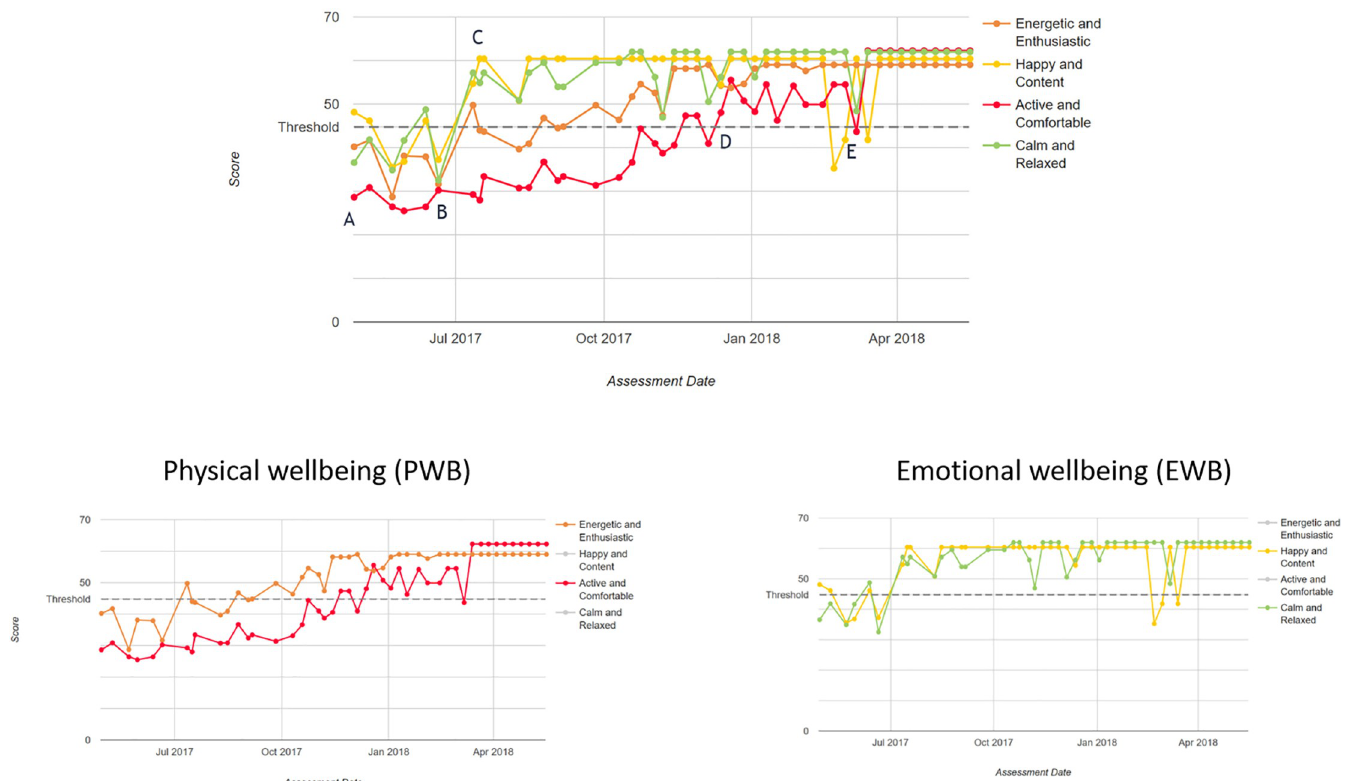
Fig 5. HRQL scores in 4 domains for an 11 year old Sharpei dog with osteoarthritis (OA) and inflammatory bowel disease (IBD), treated over 11 months. A–B treatment with acupuncture; C onwards, lifestyle changes, hydrotherapy, laser; E flare-up of